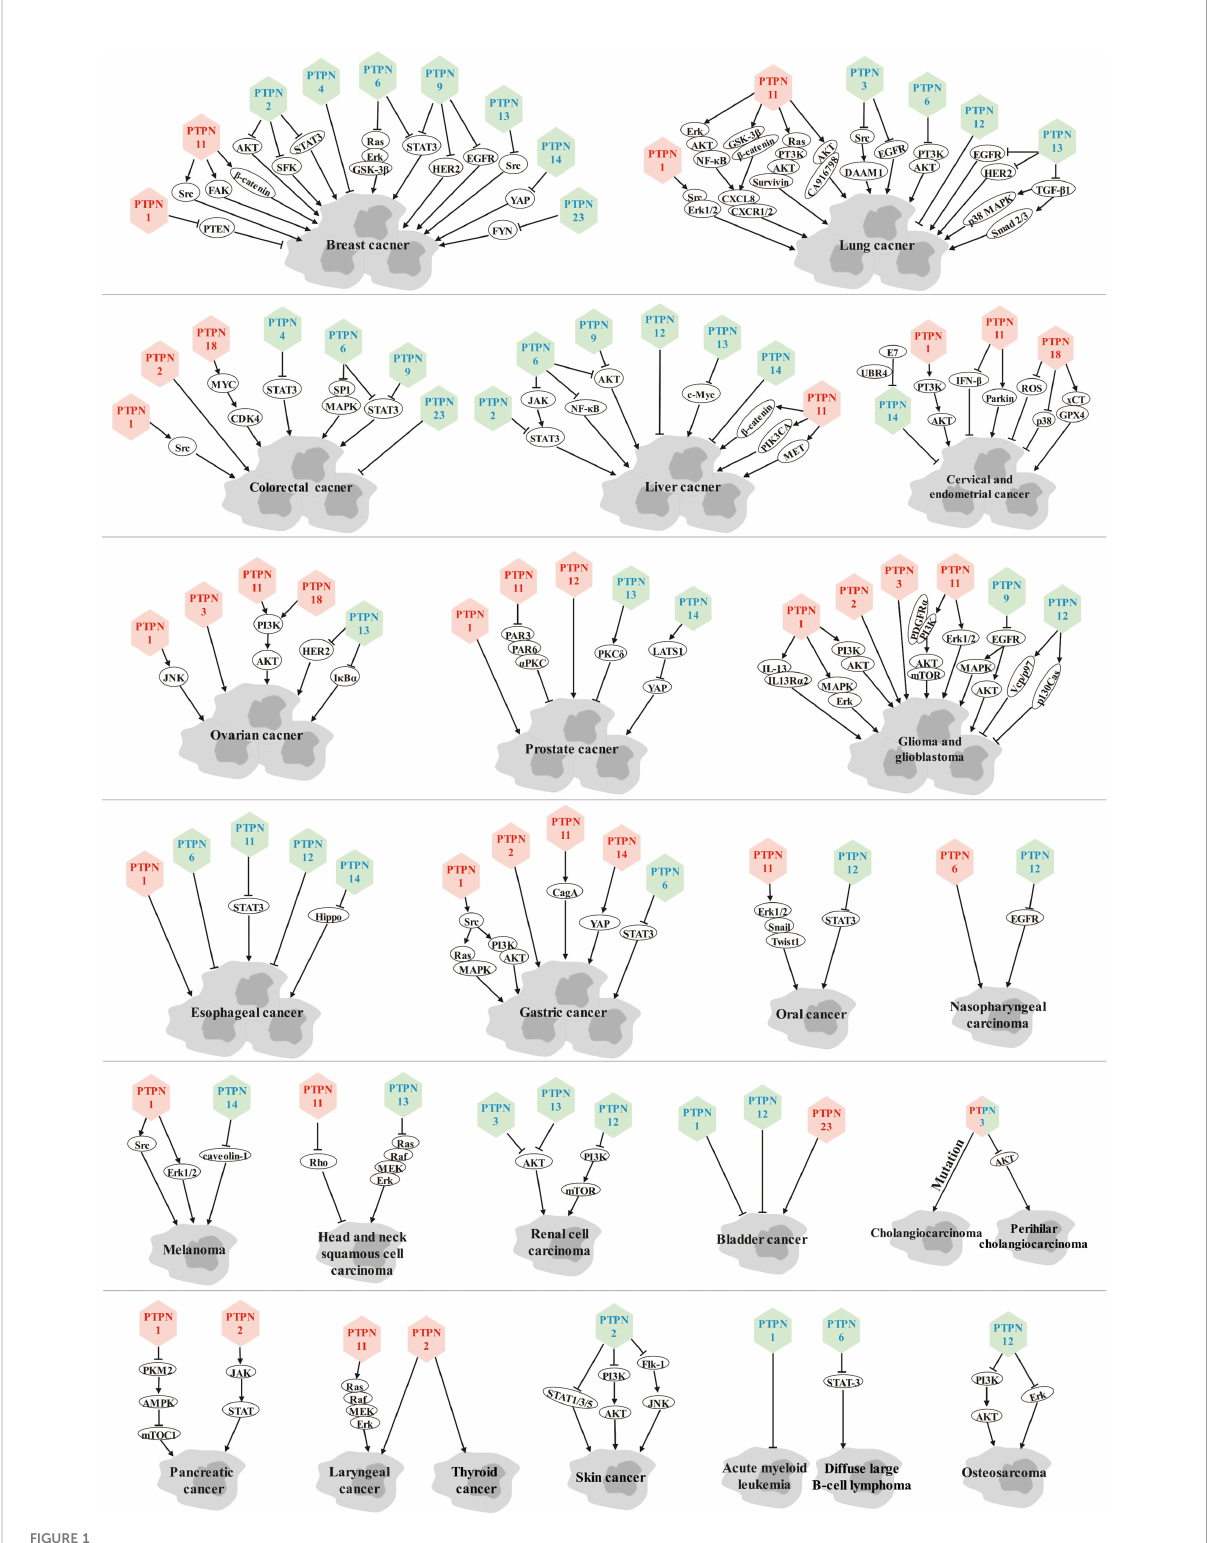
FIGURE 1 Role of PTPN family members in various cancers. Red font represents tumor promoters and blue font represents tumor